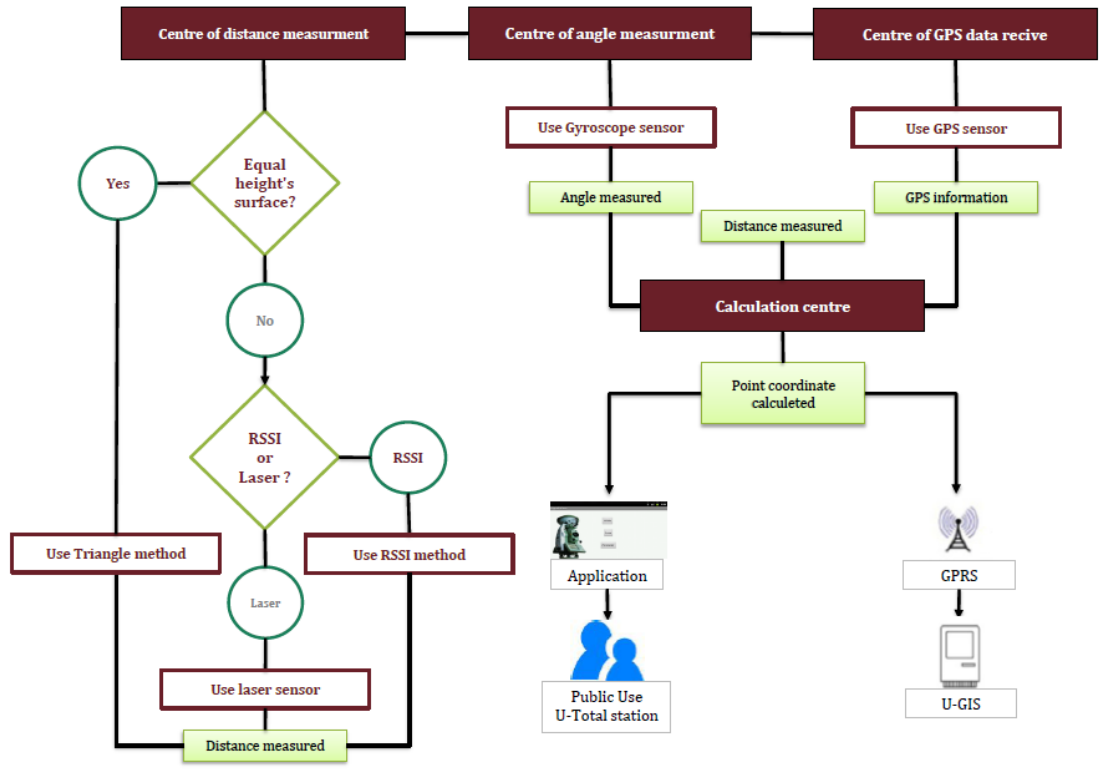
Figure1. Conceptual diagram of Smartphone-based system designed for this study: the Ubi-Total Station application developed for this study using an Android 3.2